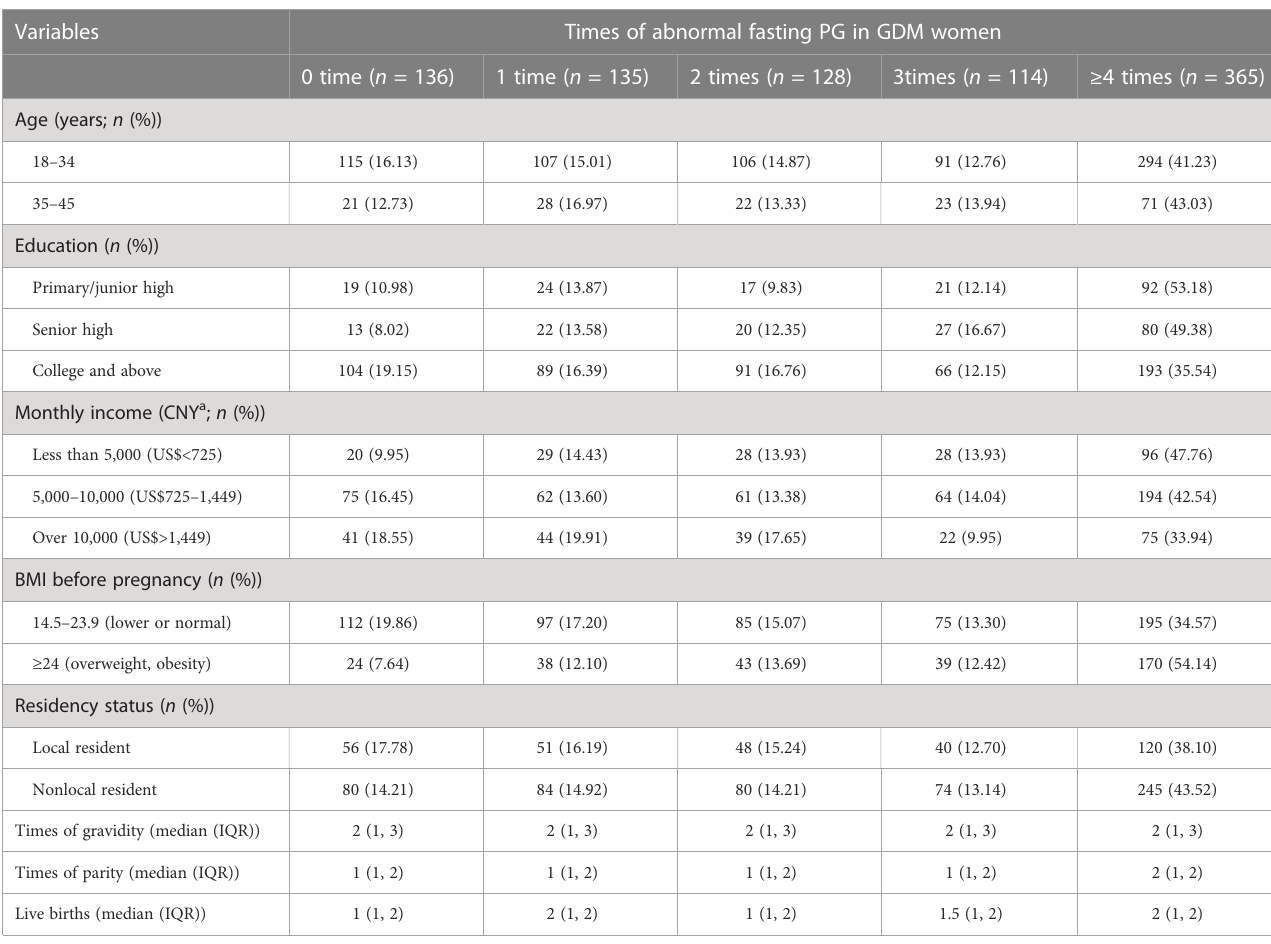
TABLE 4 Abnormal fasting plasma glucose (FPG) times in gestational diabetes mellitus (GDM) women with seven routine antenatal checkups in Shanghai, China ( n = 878). Variables Times of abnormal fasting PG in GDM women